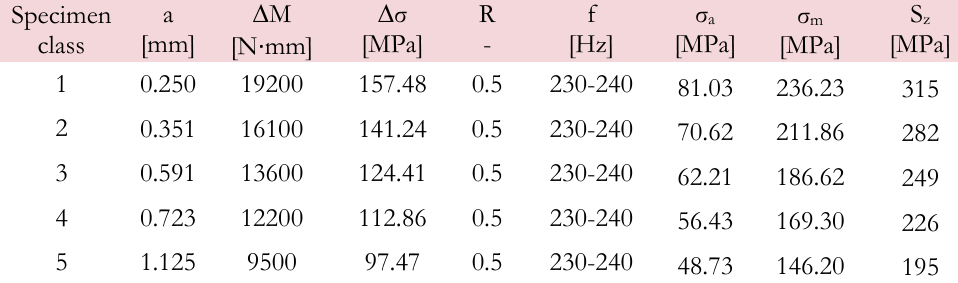
Table 3: Examination conditions and fatigue strength properties.